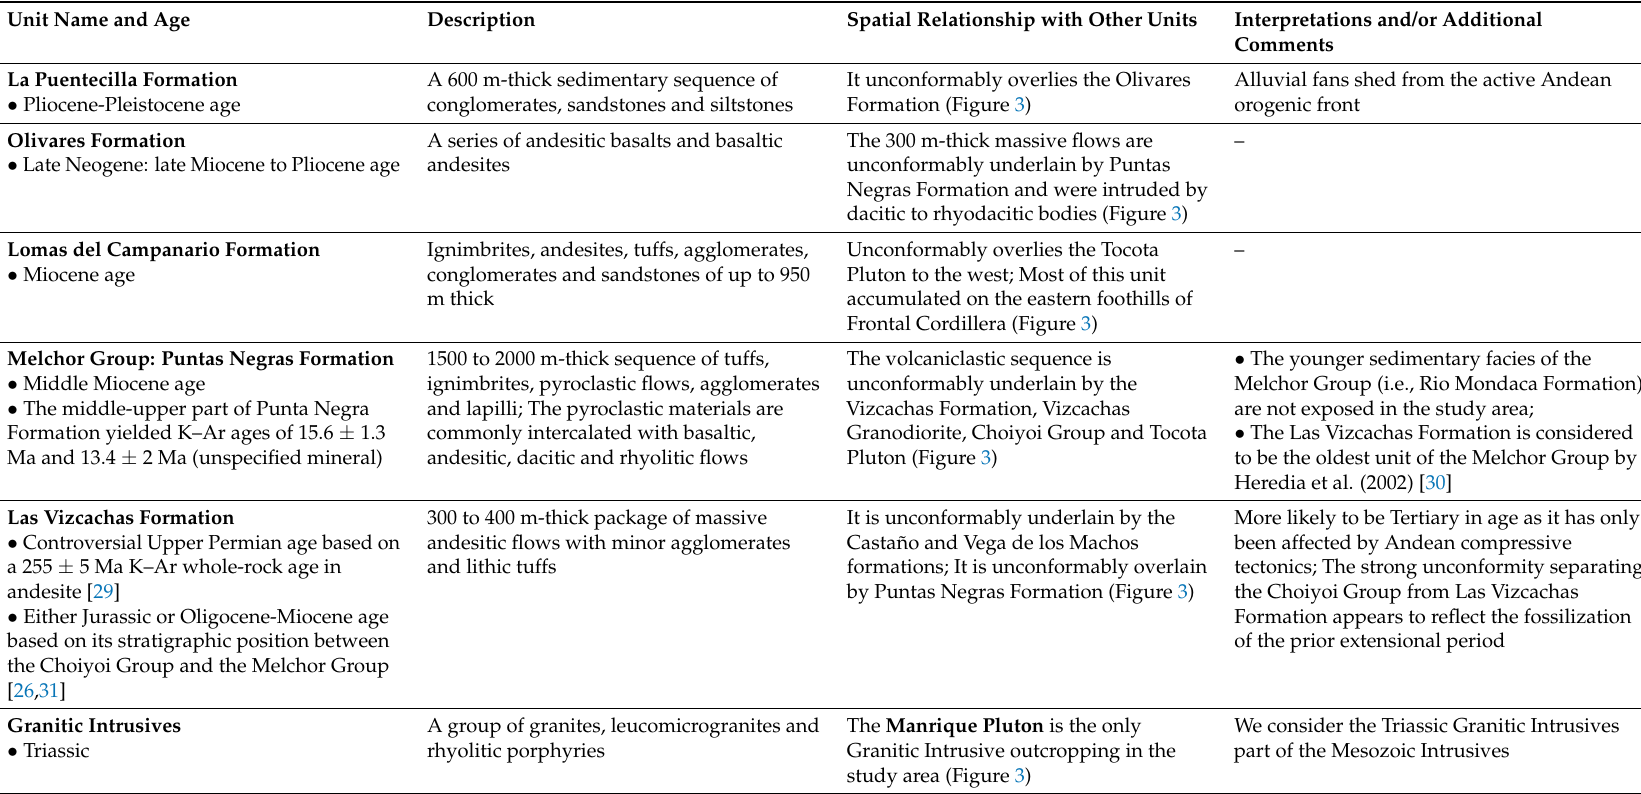
Table A1. Summary of geologic units present in the study area (cf. Figure 3) based on selected literature [21,26–32]. Key features including age, lithology type, and spatial relationship between units are included in this stratigraphic table. Geologic units are listed in order of increasing age, the youngest at the top and the oldest at the